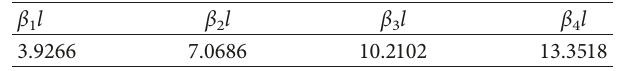
Table 2: The values of β i l for clamped-pinned